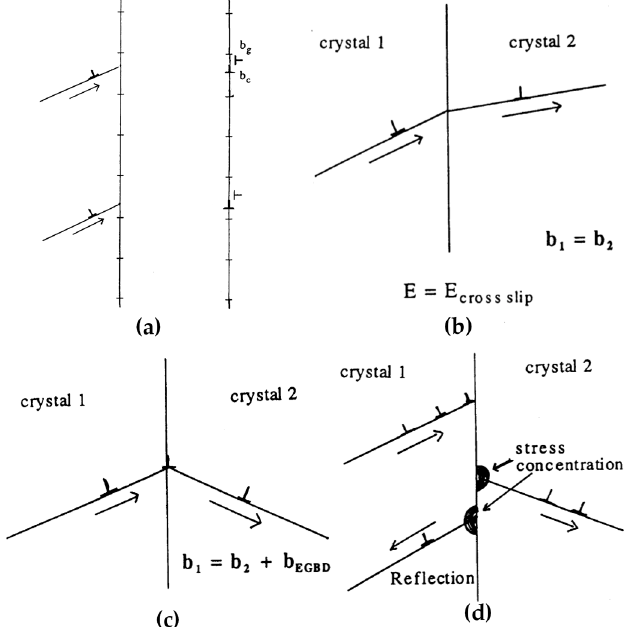
Figure 12. Three types of interactions between dislocations and grain boundaries. The schematic illustrations of ( a ) absorption; ( b ) transmission without residual dislocation; ( c ) transmission leaving residual dislocation; ( d ) reflection, respectively. (Reprinted from Reference [33], with permission from Elsevier).